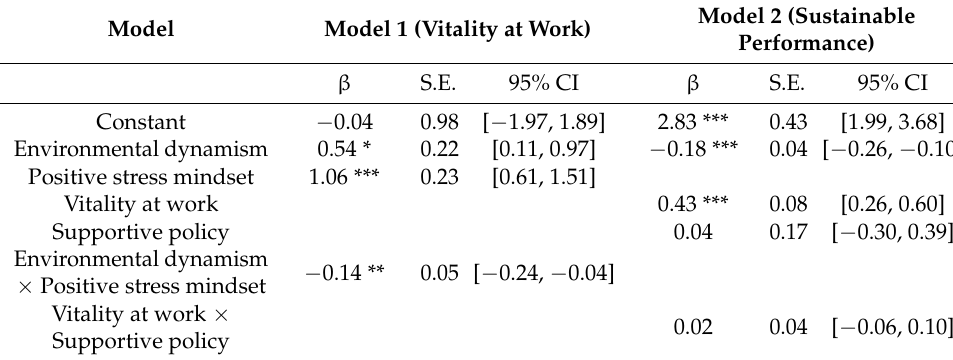
Table 5. Estimates and confidence intervals for the moderating roles.